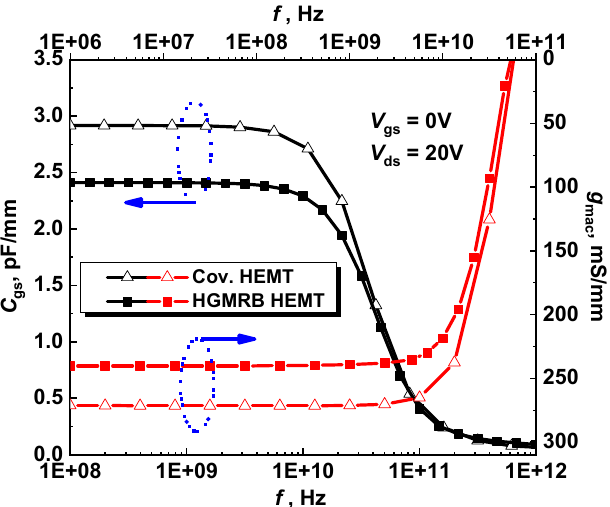
Figure 7. Gate-source capacitance ( C gs ) and transconductance ( g m ) versus frequency of the two devices at V gs = 0V, V ds = 20V.